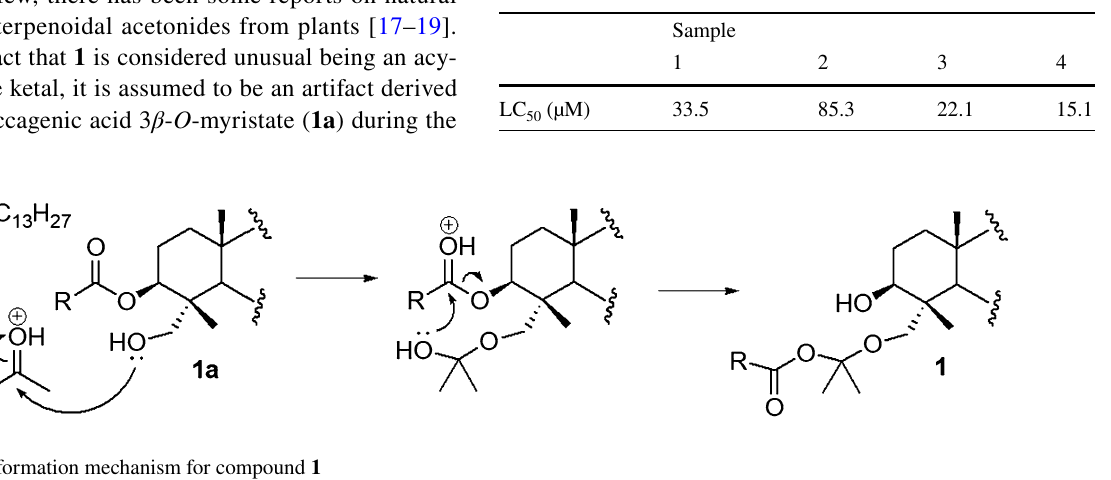
Fig. 2 Possible formation mechanism for compound 1